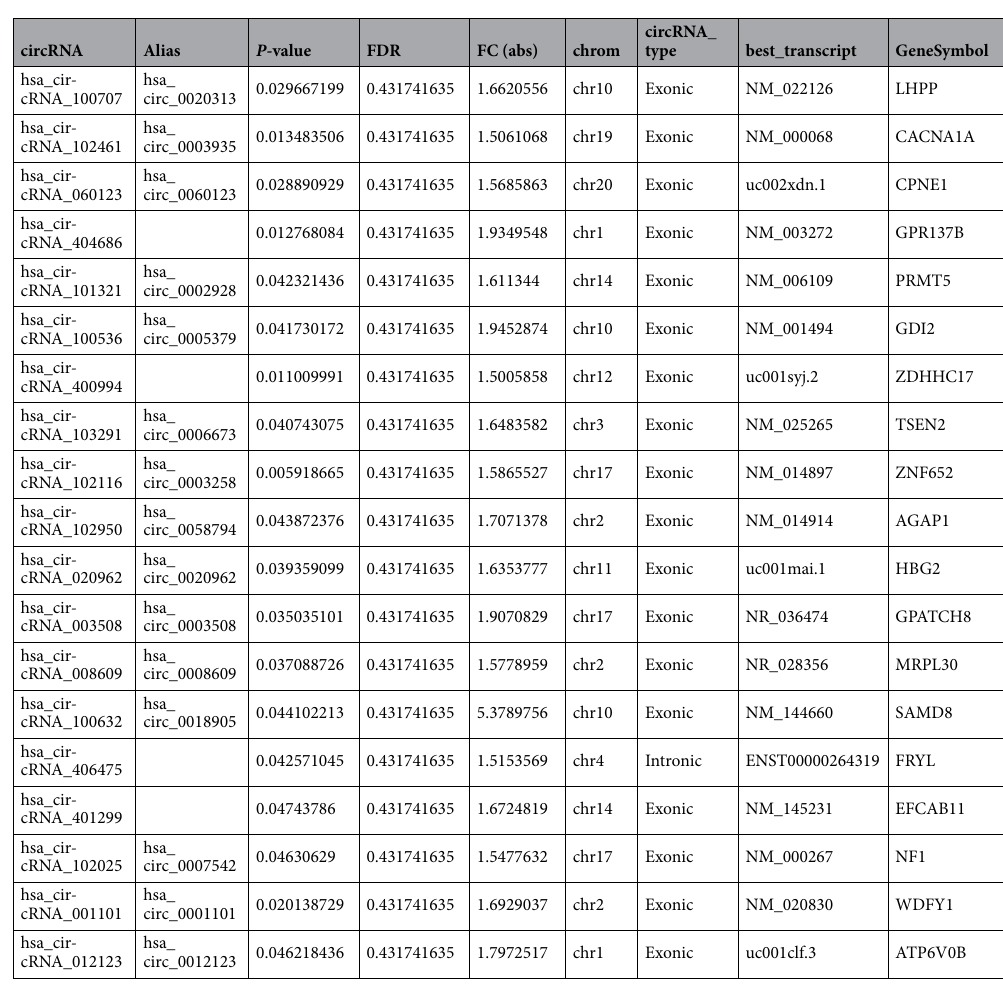
Table 4. Differentially down-regulated circRNAs in serum exosomes of patients with sepsis. FDR: false discover rate; FC: fold